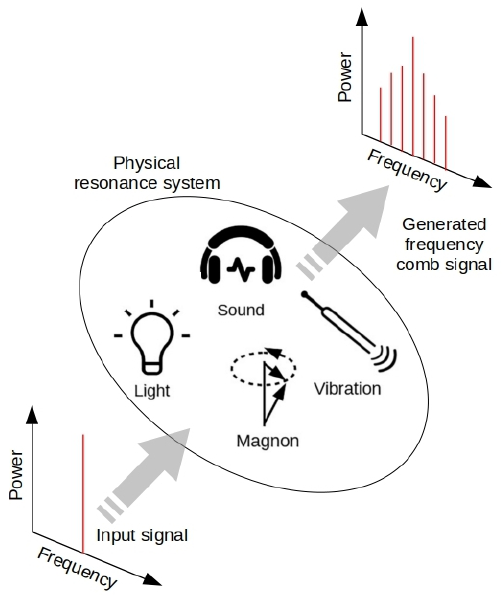
Figure 1. Conceptual illustration of the physical mechanisms of FC generation, where a resonant interaction of a single-frequency input signal with light, sound, vibrations and magnons—the quanta of spin waves—results in the appearance of equidistant coherent peaks in the power spectrum of the output signal. As demonstrated in this review article, an FC spectrum can be produced using either a sole resonant physical process or a combination of them, which is, for example, the case of Brillouin light scattering from phonons and